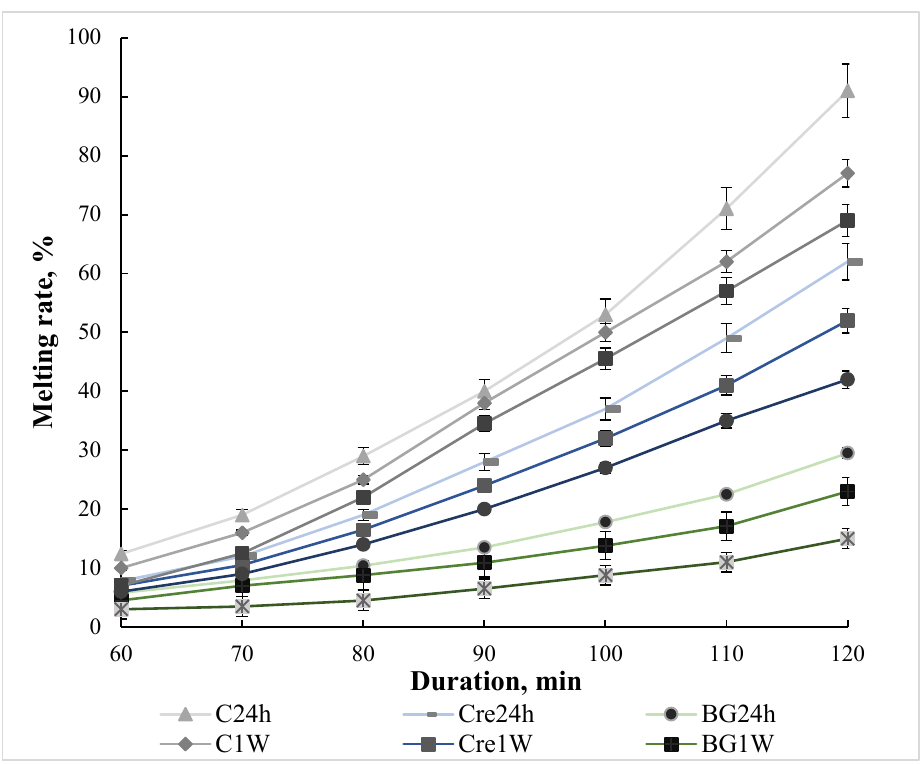
Figure 3. Ice cream melting rate after different times of storage (24 h, 1 week (1 W), and 1 month (1 M)): C is low-fat milky ice cream without stabilizer (control); Cre is low-fat milky ice cream with 0.5% of Cremodan ® SI 320; BG is low-fat milky ice cream with 0.5% of oat β -glucan ( p ≤ 0.05).